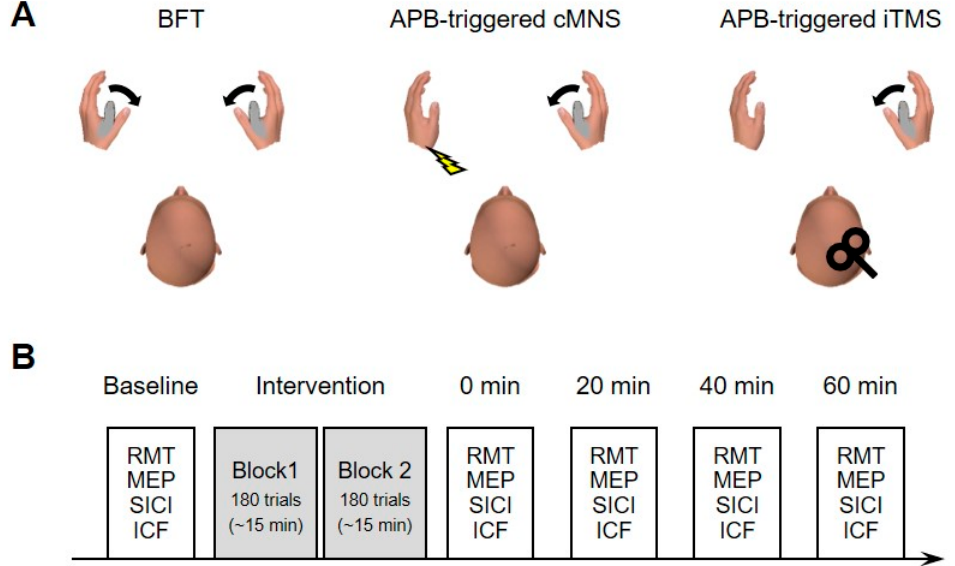
Figure 1. ( A ) Experimental protocol: Schematic illustration of the intervention protocols. ( B ) Time course of each experiment session.